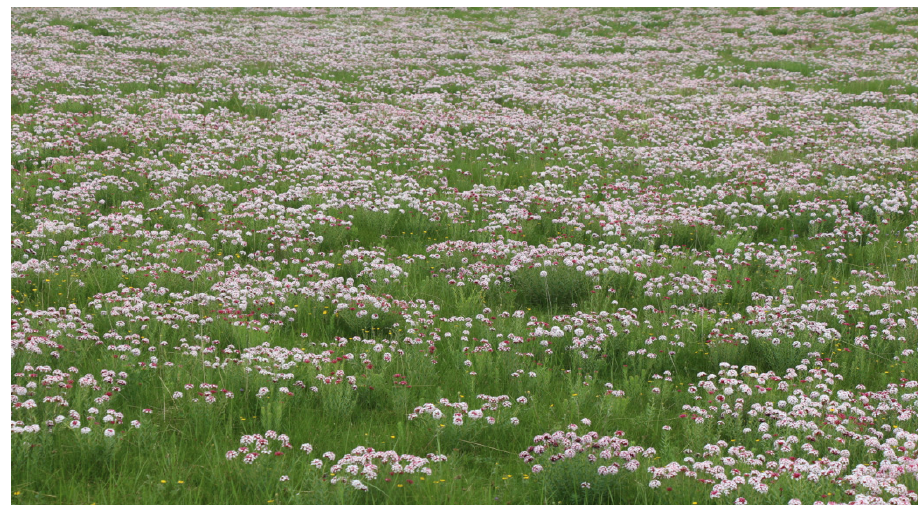
Figure 5. Distribution of the S. chamaejasme community in the study area, in Baishiya Village, Ebao Town, Qilian County, China (38°02 ′ 33.77 ″ N, 100°32 ′ 01.82 ″ E). The average coverage of the S. chamaejasme community in an alpine meadow is about 60%.